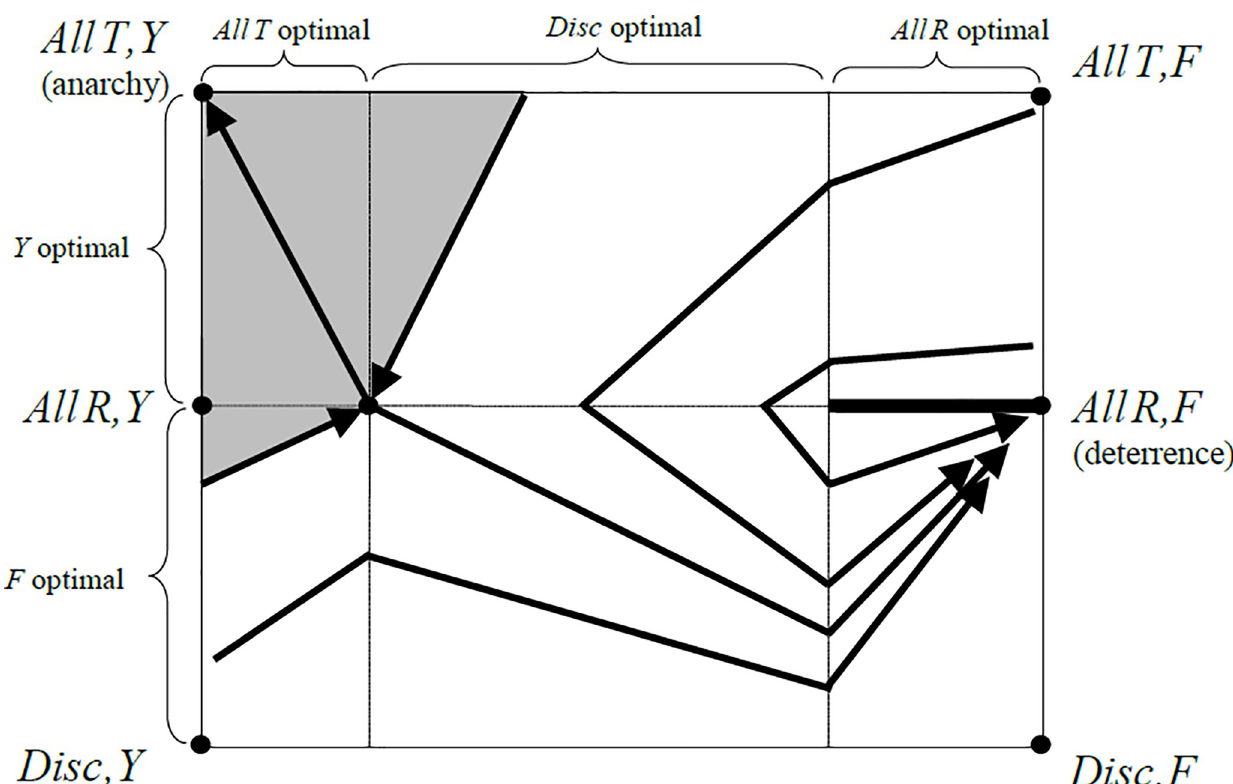
Fig 4. Projected best response paths for the evolutionary deterrence game. For initial population states close to the no-deterrence ESS ( AllT , Y ) deterrence fails to evolve. The shaded region is the basin of attraction of this anarchistic ESS. Outside this region, best response paths converge to the deterrence equilibrium at ( AllR , F ). This equilibrium is embedded in a stable component of equilibria with full deterrence. Discriminators die out in the long run, but they play an important role in steering evolving populations to full deterrence. Parameter values: v = c = 1, a = 0.2.